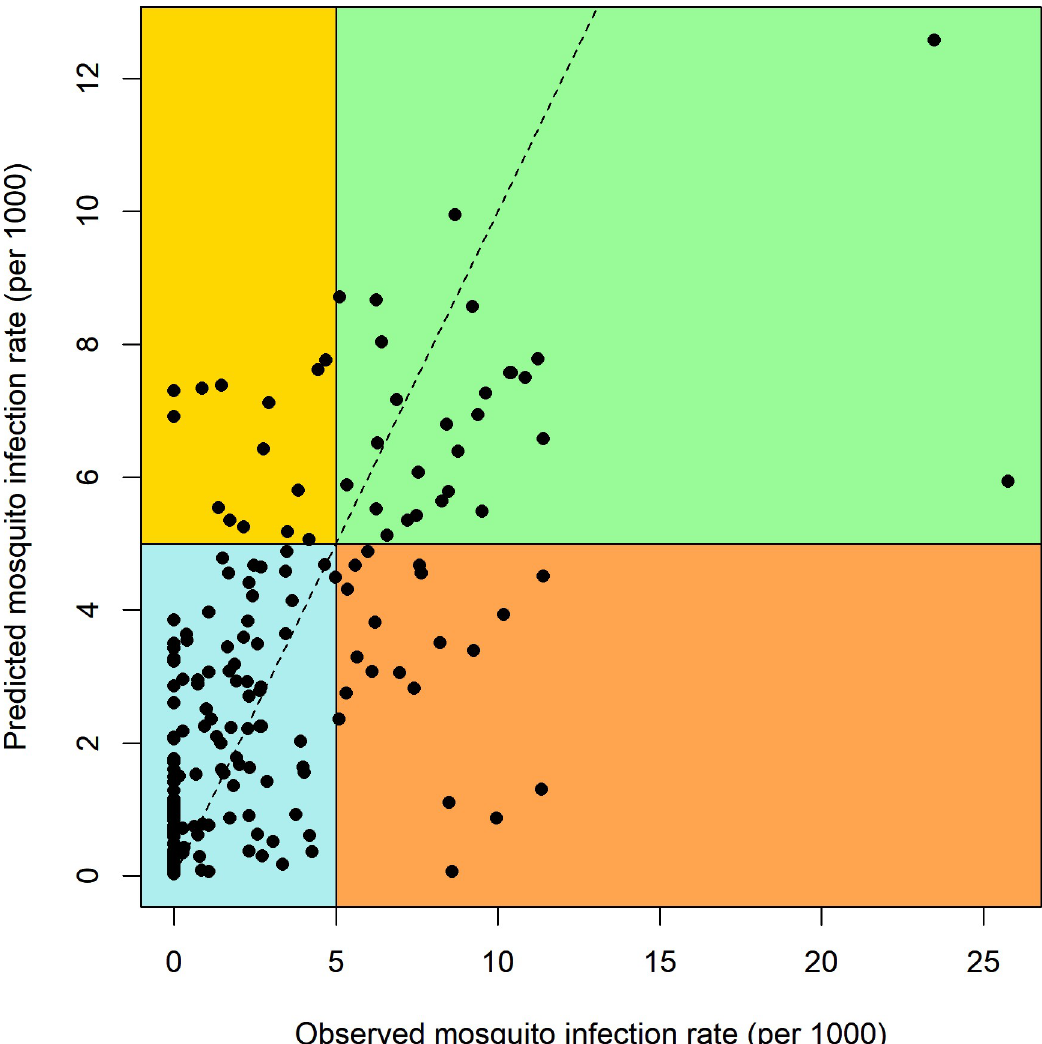
Fig 1. Observed mosquito infection rate ( MLE ) vs. predicted MLE from the WNV model using the entire data set. Background colors correspond to a classification of model predictions based on MLE of 5 [22]. Green corresponds to a correct prediction of high WNV MLE (27 records, 12.4%), blue corresponds to a correct prediction of low WNV MLE (157 records, 72.0%). Yellow corresponds to an error where the model predicts MLE to be high, but it is not (14 records, 6.4%), whereas orange corresponds to an error where the model predicts MLE to be low, but MLE was high (20 records, 9.2%). Future models should aim to improve the model’s sensitivity (0.57), although the specificity (0.92) is also of concern. Note that some predictions can be quite accurate, and still result in misclassification if they are near the classification